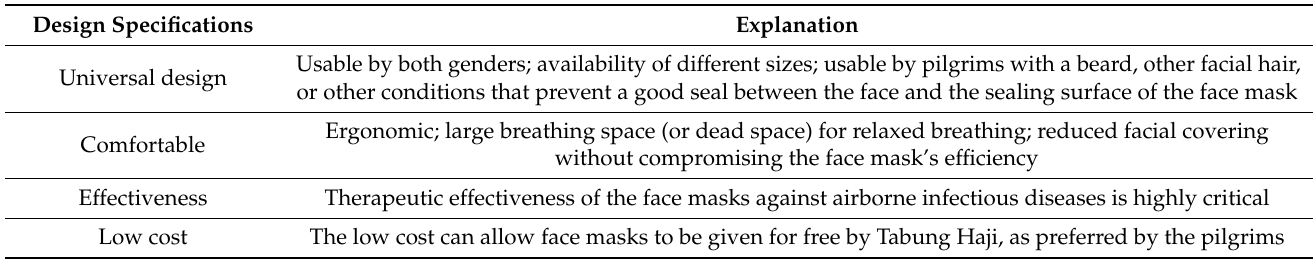
Table 4. Product design specification (PDS).